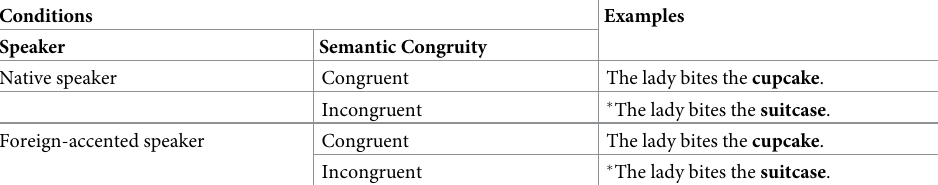
Table 1. Experimental design with example sentences. Target word is in